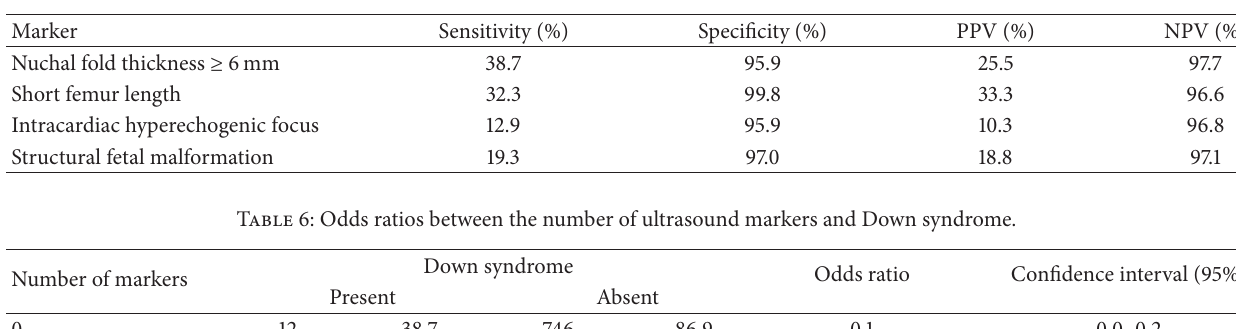
Table 5: Sensitivity, specificity, positive predictive value (PPV), and negative predictive value (NPV) of the ultrasound markers for detecting Down syndrome.